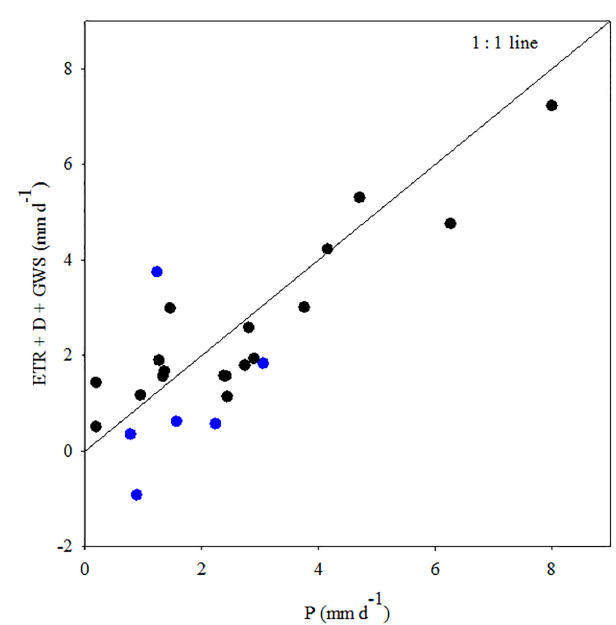
Figure 3. Monthly water mass balance at the Bilos site for the 2014–2015 period. Pearson coefficient R = 0.85 and p value<0.001. Blue points represent months when groundwater storage was extremely negative in March 2014, April 2014, March 2015, April 2015, June 2015 and July 2015 (Fig. 2c). These blue points are further away from the 1:1 line than the other months (represented in black). The drainage of the Leyre river is delayed compared to the drainage of the Bilos plot. Thus, when the loss of groundwater is extremely high (negative groundwater storage), estimated drainage does not correspond exactly to the measured groundwater